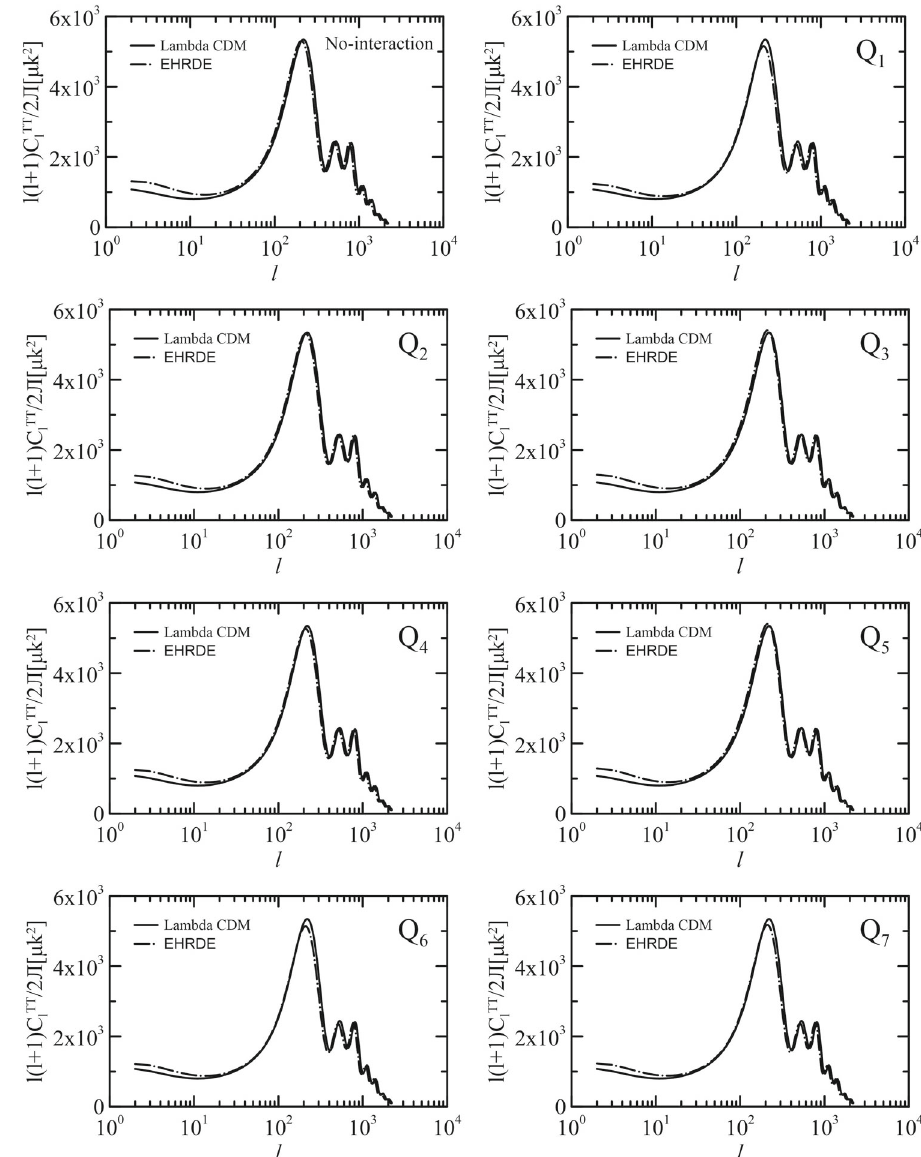
Fig. 6 The CMB temperature spectra c TT (cid:4) of the EHRDE (see Eqs. (21), (22)) with interaction terms listed in Table 1. All models’ (cid:5) D and H 0 ≡ 100 h [ km / s · Mpc ] parameter are set as their best fitting values from Table 4 and 5. All models have equal